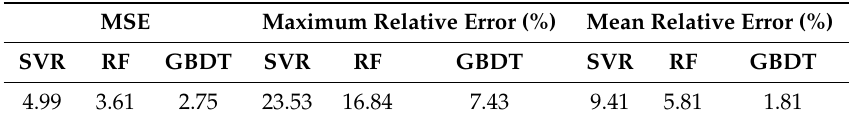
Table 3. Model prediction error comparison.